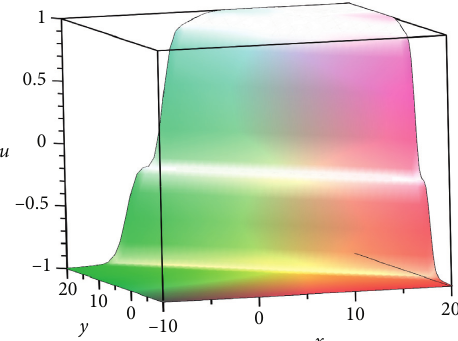
Figure 2: Spatiotemporal structure of solution (16) with parameter � 1, a � 1, a � 1, α � 1, and β � selections: a 5 6 9